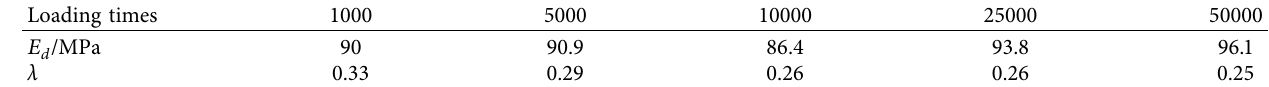
Table 2: The dynamic modulus and damping